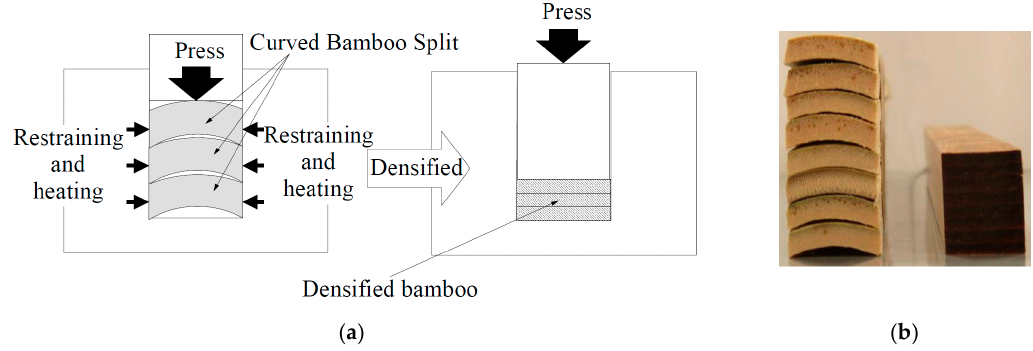
Figure 13. ( a ) Densification process used by Tanaka et al. (2006) [68] and ( b ) bamboo samples before and after the densification process [68].